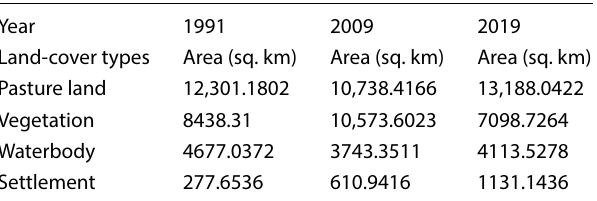
Table 9 Changes in land uses from classified land